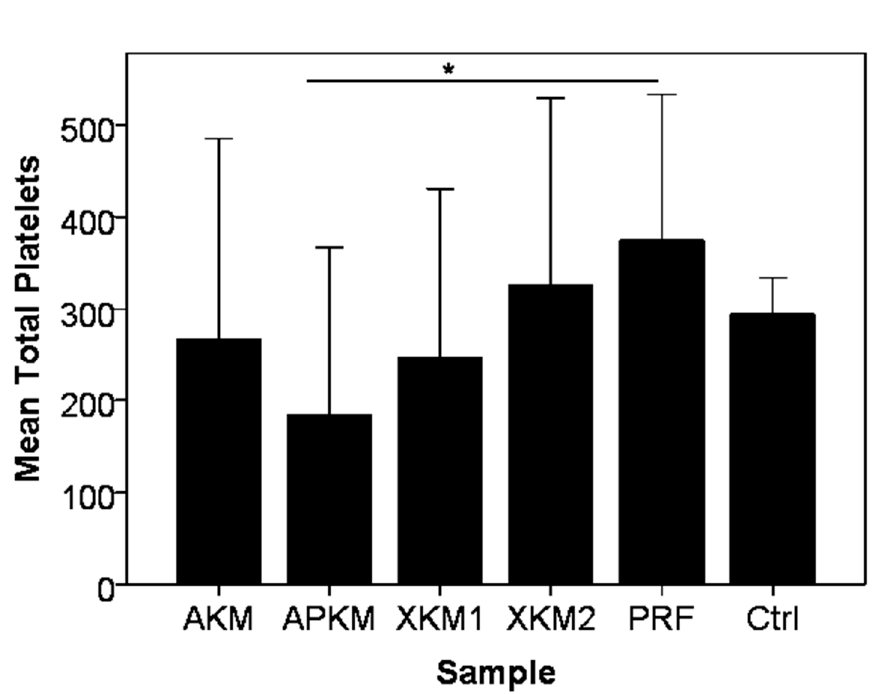
Figure 3. Total platelet count × 10 3 / µ L after 15 min of incubation of each BSM with PRF in compari- son to PRF alone and EDTA blood (Ctrl: control). In comparison to PRF alone, all BSMs led to an active platelet consumption, with a significant difference for APKM vs. PRF (* p = 0.05). In the ELISA experiment, the combination of BSMs with PRF led to a slightly decreased expression of VEGF when compared to PRF alone (AKM: p = 0.161; APKM: p = 0.089; XKM1: p = 0.098; and XKM2: p = 0.174). Between the groups, no significant differences could be detected ( p = 0.35). For TGFß, both xenogeneic BSMs (XKM1 and XKM2) showed an increased expression in comparison to PRF alone but also failed to reach statistical significance (AKM: p = 0.512; APKM: p = 0.775; XKM1: p = 0.285; and XKM2: p = 0.838). Furthermore, no significant differences between the samples could be seen ( p = 0.48). For PDGF, a significantly decreased expression in comparison to PRF alone was shown for all BSMs (AKM: p = 0.003; APKM: p = 0.002; XKM1: p = 0.004; and XKM2: p = 0.013). The differences between the groups were statistically significant ( p = 0.009; Table 2A–C and Figure